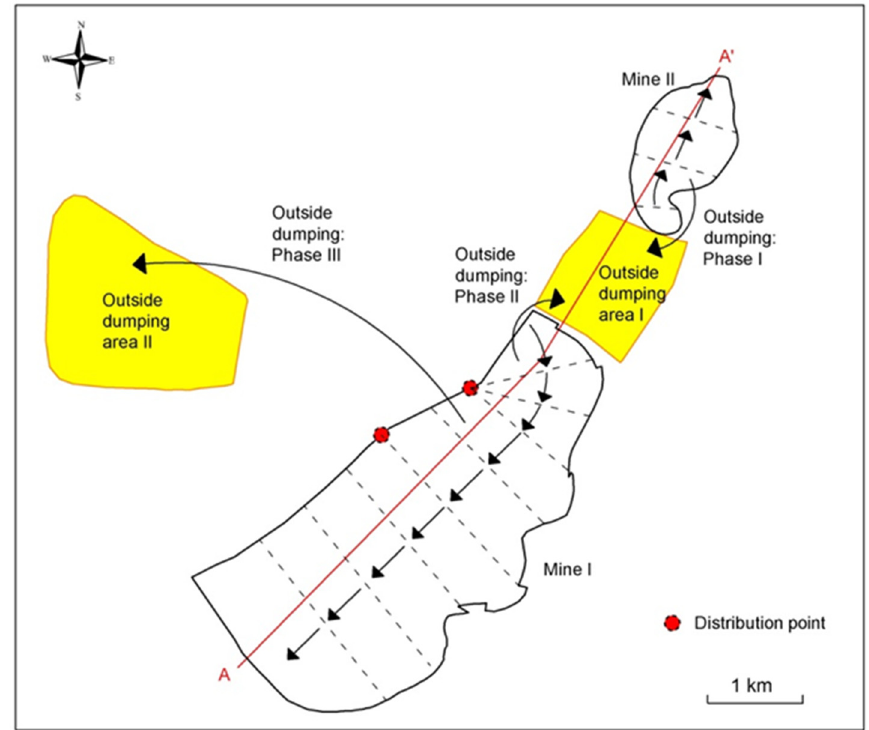
Figure 3. Strategic mine development.